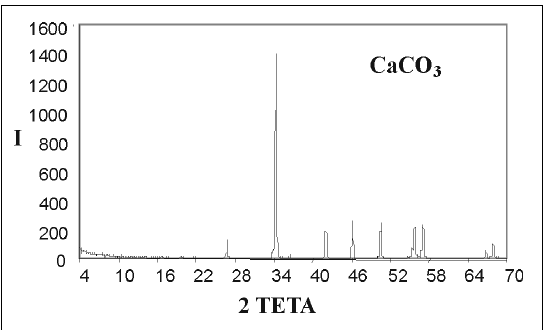
Fig. 2. X-rays diffractogram of filler